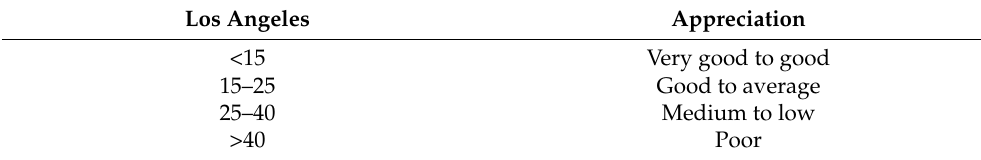
Table 6. Order of magnitude and appreciation of the Los Angeles coefficient (CEBTP, 1984).